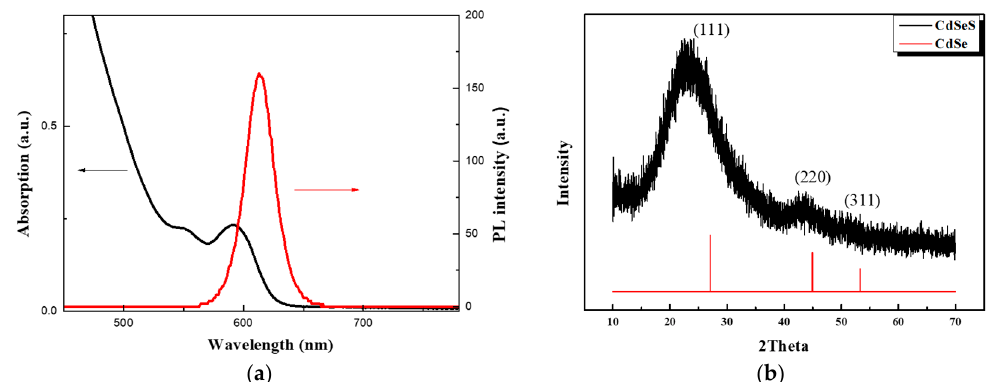
Figure 1. ( a ) Absorption and photoluminescence spectra and ( b ) X-ray diffraction (XRD) patterns of CdSeS/ZnS